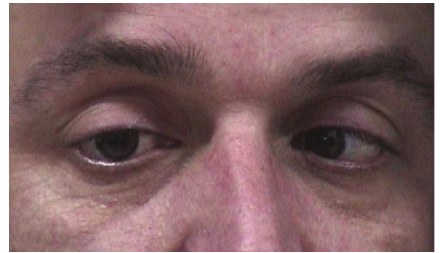
Figure 8: Underaction of right eye on dextroversion.